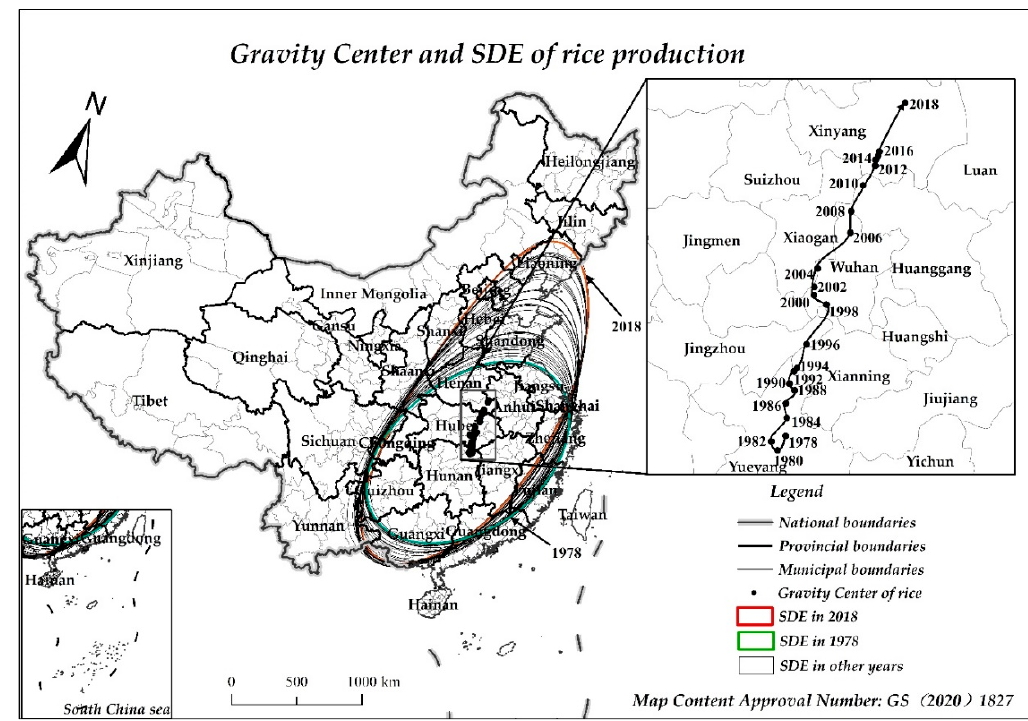
Figure 5. The GC and Standard Deviation Elliptic of rice production in China since 1978.